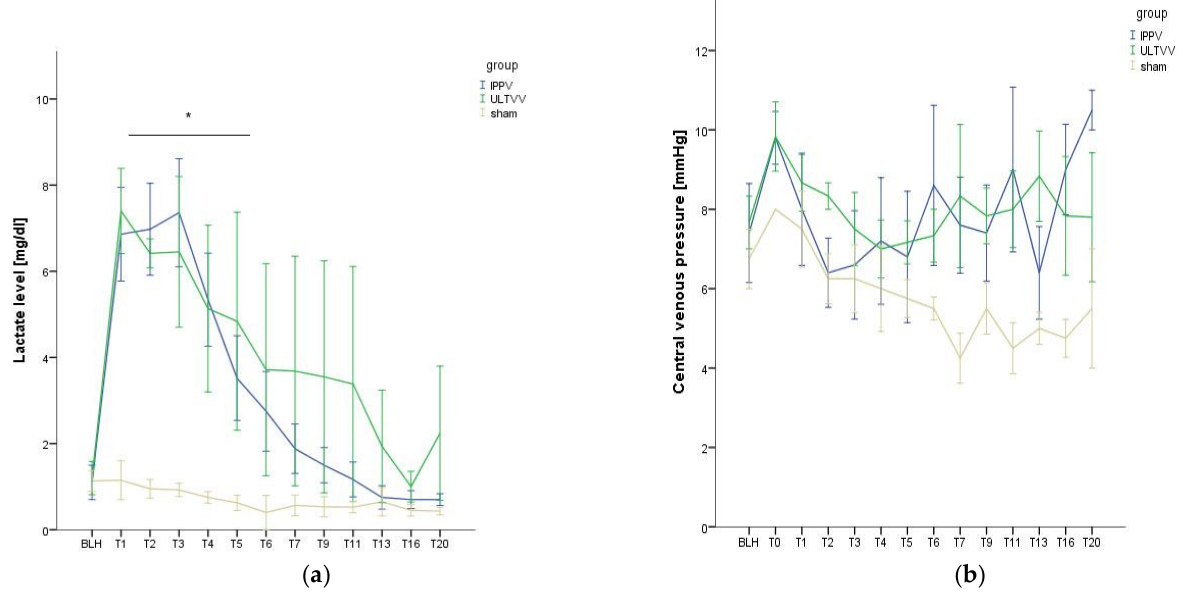
Figure 1. Hemodynamic stability. ( a ) Lactate levels as a function of time. ( b ) Central venous pressure as a function of time. Mean (±1 SE). * indicates p < 0.05 ULTVV and IPPV vs. sham treatment. BLH: baseline healthy. IPPV: Intermient positive pressure ventilation. ULTVV: Ultra-low tidal volume ventilation. Tx: timepoint.